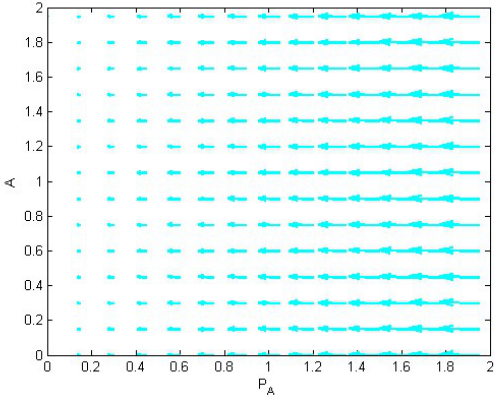
Figure 4. Intensity of pre-AIDS class versus AIDS class.